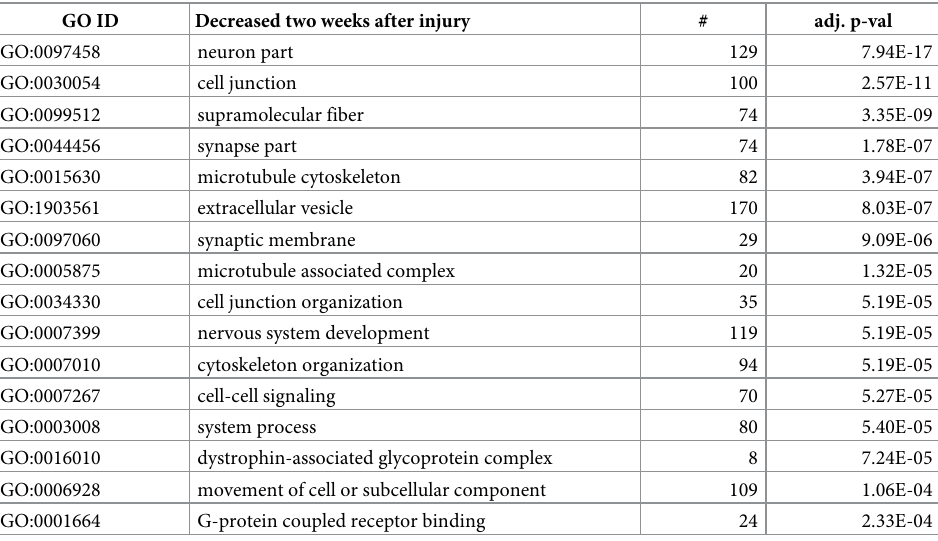
Table 4. The top significantly downregulated GO Pathways after nerve injury, the # of proteins in each pathway that were found to be significant, and their overrepresentation adjusted